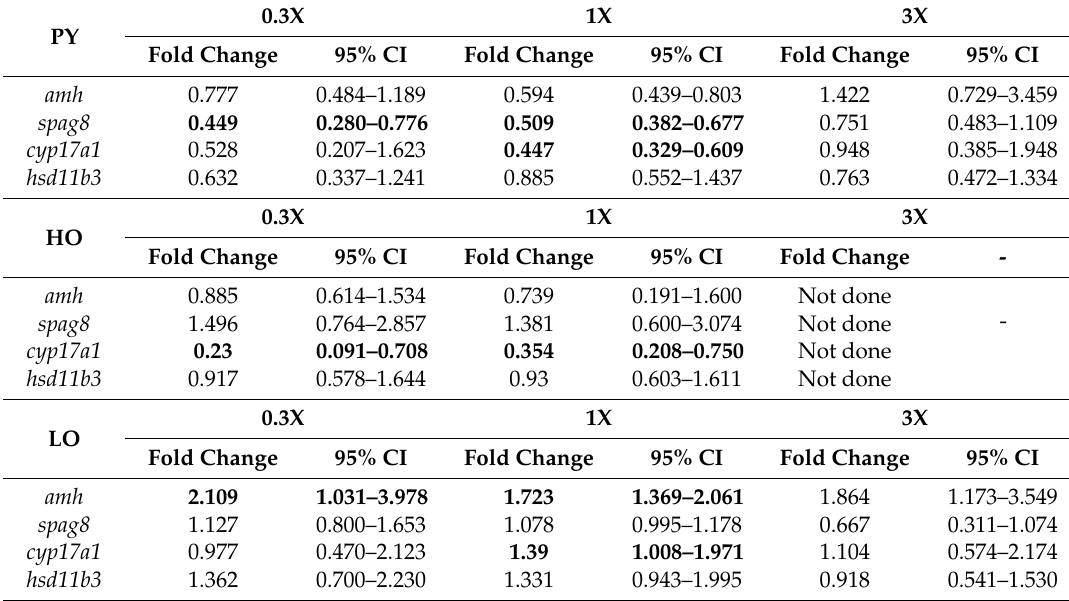
Table 3. qPCR genes expression analysis in testis of exposed